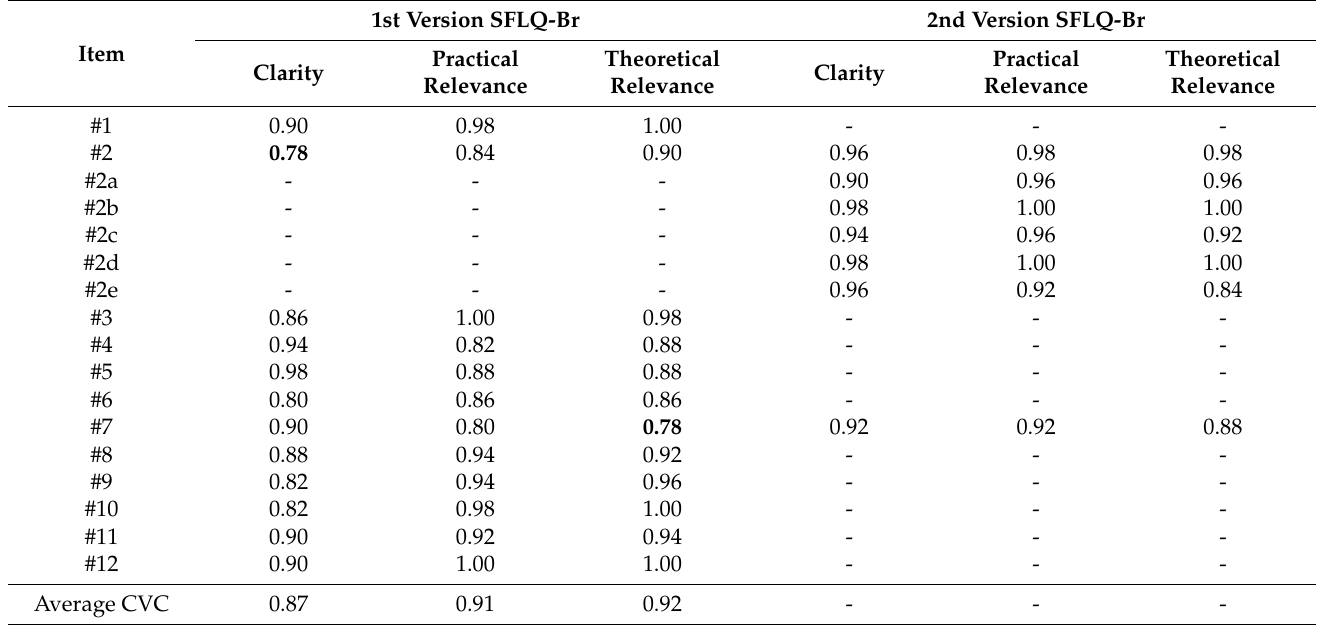
Table 3. Average CVCi of the SFLQ-Br based on judge’s